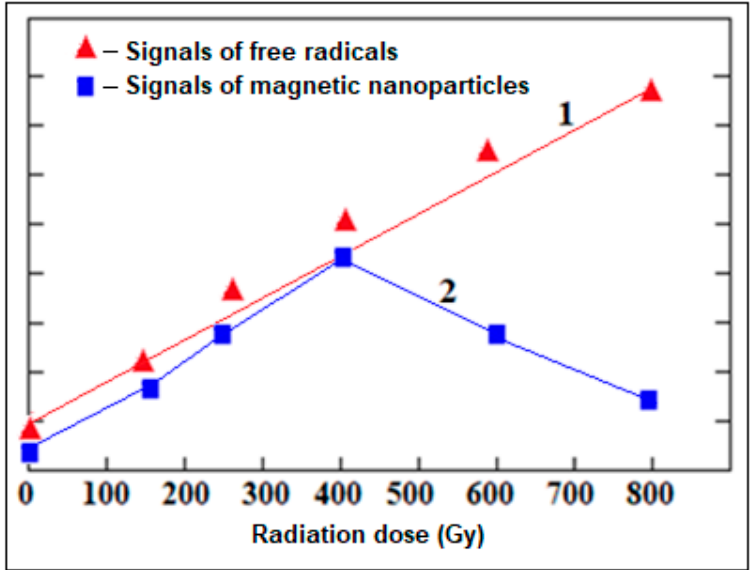
Figure 6. Dependence of the intensities of free radical signals (1) and broad EPR signals character- izing magnetic iron oxide nanoparticles (2) recorded in the shell parts of grape snails on the radia- tion dose.